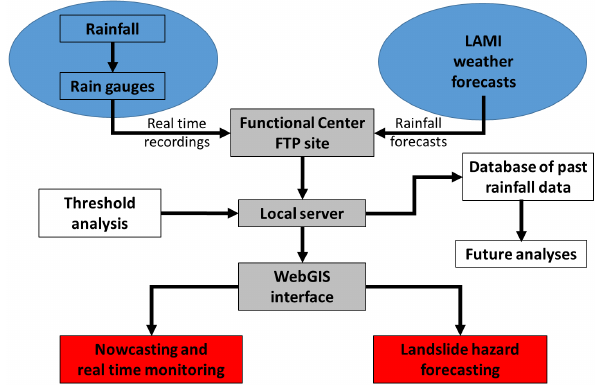
Figure 2. Architecture of the early warning system.